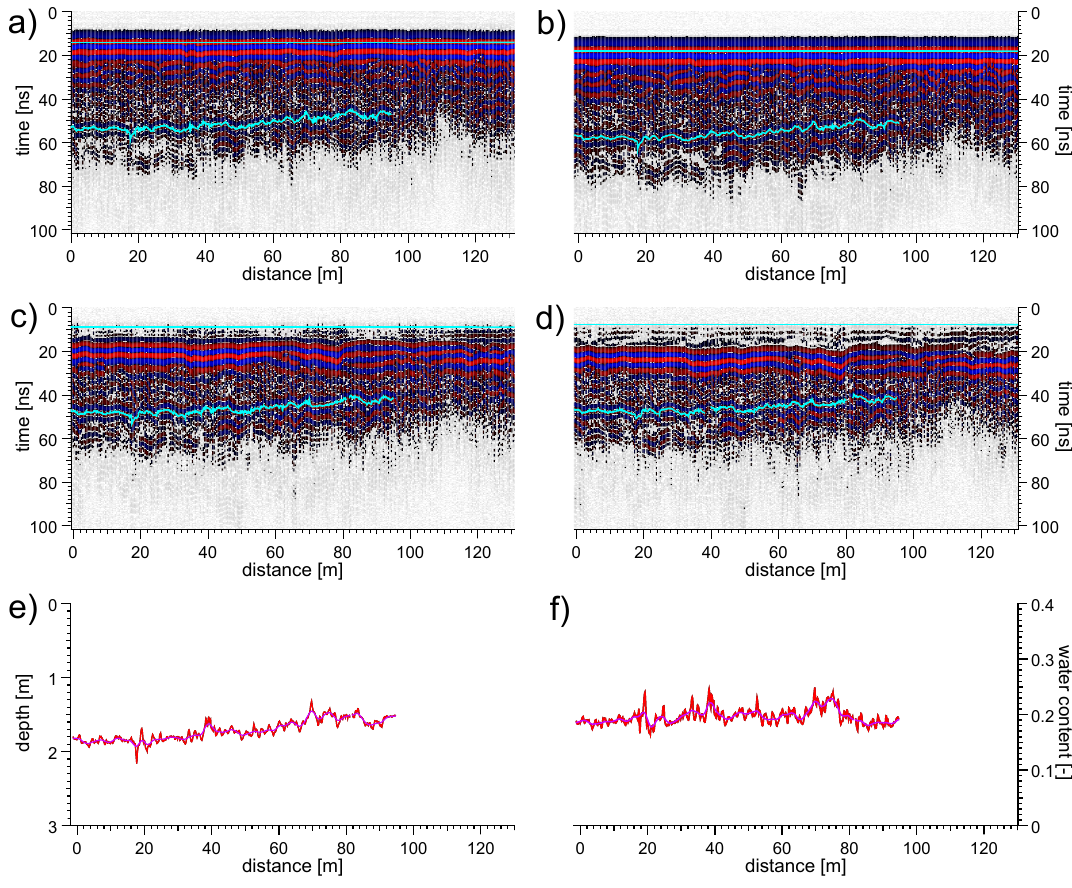
Fig. 2. Transect T1: Radar traces of all four channels and resulting evaluation on 14 August 2008. (a) and (b) : antenna separation 0.31m; (c) 1.59m; (d) 2.21m; (e) and (f) resulting thaw depth and volumetric soil water content (red: raw data; purple: smoothed data). It is not possible to evaluate the radargrams beyond about